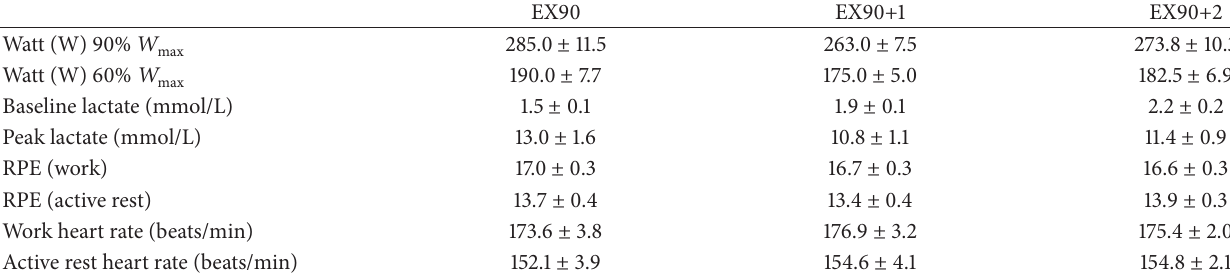
Table 3: Exercise data for EX90, EX90+1, and EX90+2 groups (mean ± SE).